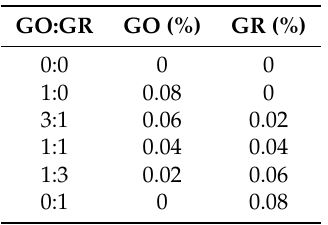
Table 1. The mass ratios of GO and grapheme (GR) in GO/GR hybrid and corresponding concentrations in mortar (%, relative to the mass of cement).